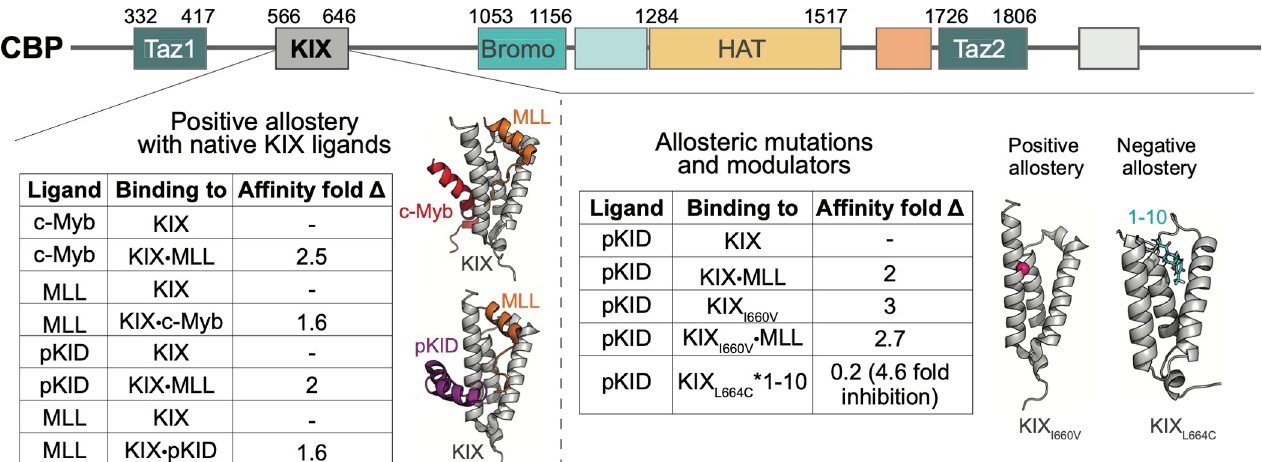
Fig 1. (Top) The various domains of CBP. (Left) Positive cooperativity is seen in the two native KIX systems (c-Myb and pKID, respectively). Affinity fold changes were calculated using K d s obtained from ITC [23]. The two solution NMR structures of the ternary complexes (c-Myb•KIX•MLL from PDB 2agh [32], and pKID•KIX•MLL from PDB 2lxt [33]) were used to construct all of the native KIX complexes for simulations (apo KIX, KIX•c-Myb, KIX•MLL,